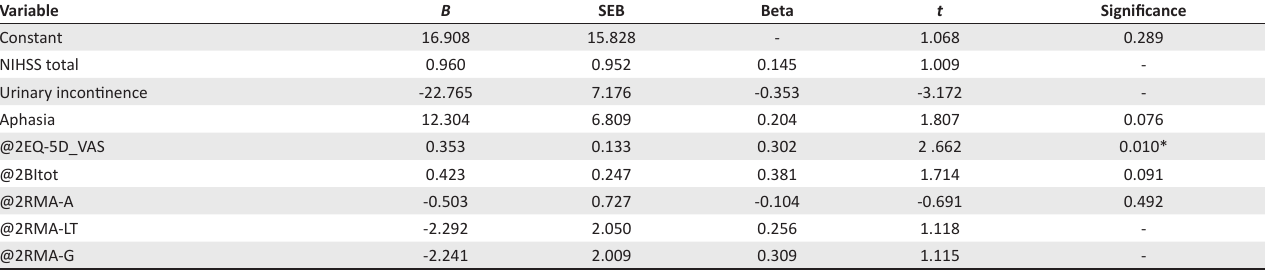
TABLE 3: Regression coefficients for factors predicting EQ-5D VAS scores at six months post stroke .